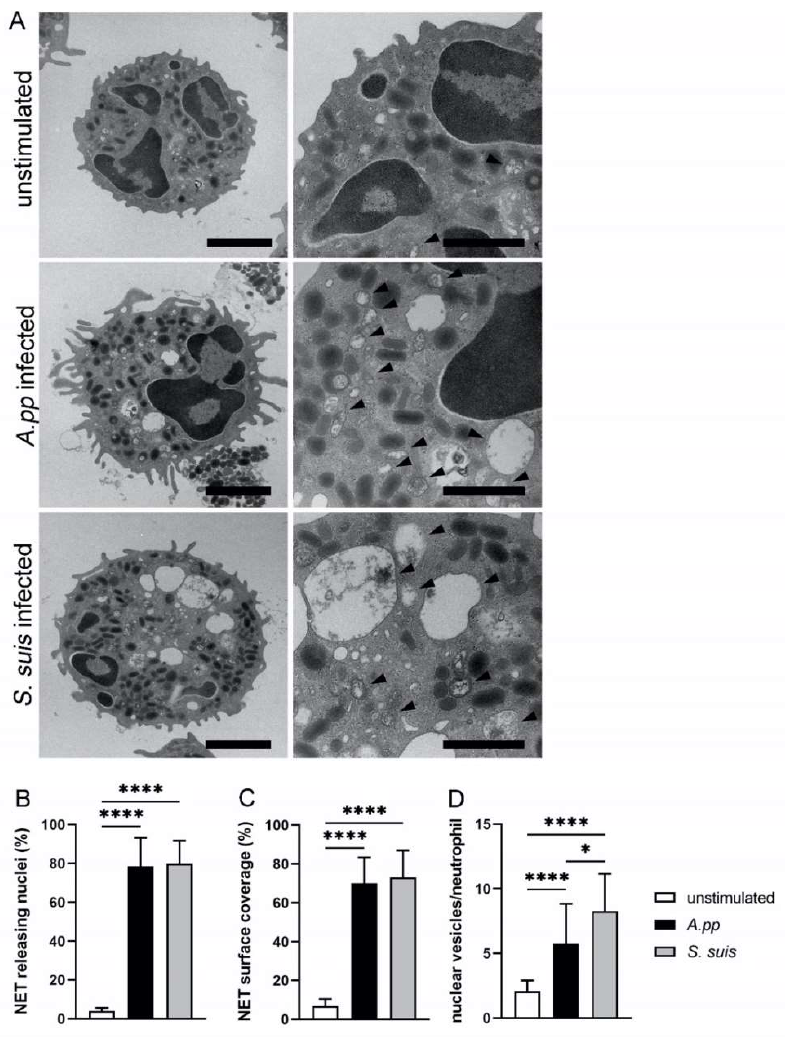
Figure 4. ( A ) Representative TEM images of porcine neutrophils after a 30 min incubation period that were used for quantification (taken from one experimental run). The arrowheads mark vesicles within the neutrophils. The scale bars are: 2 µm (left) and 1 µm (right); ( B – D ) Statistical analysis of the TEM images: In total, 30 cellular profiles from randomly selected fields on the thin sections were analyzed per sample. Neutrophils stimulated with A.pp and S. suis showed a significantly higher NET release from the nuclei (“suicidal NETosis”) ( B ); a significantly higher NET surface coverage ( C ); and a significantly higher number of nuclear vesicles (“vital NETosis”) in neutrophils, with the highest amount in S. suis infected neutrophils ( D ). Data were analyzed with the Kruskal–Wallis multiple comparison test ( n = 30) and presented with mean ± SD (* p ≤ 0.05, **** p < 0.0001).